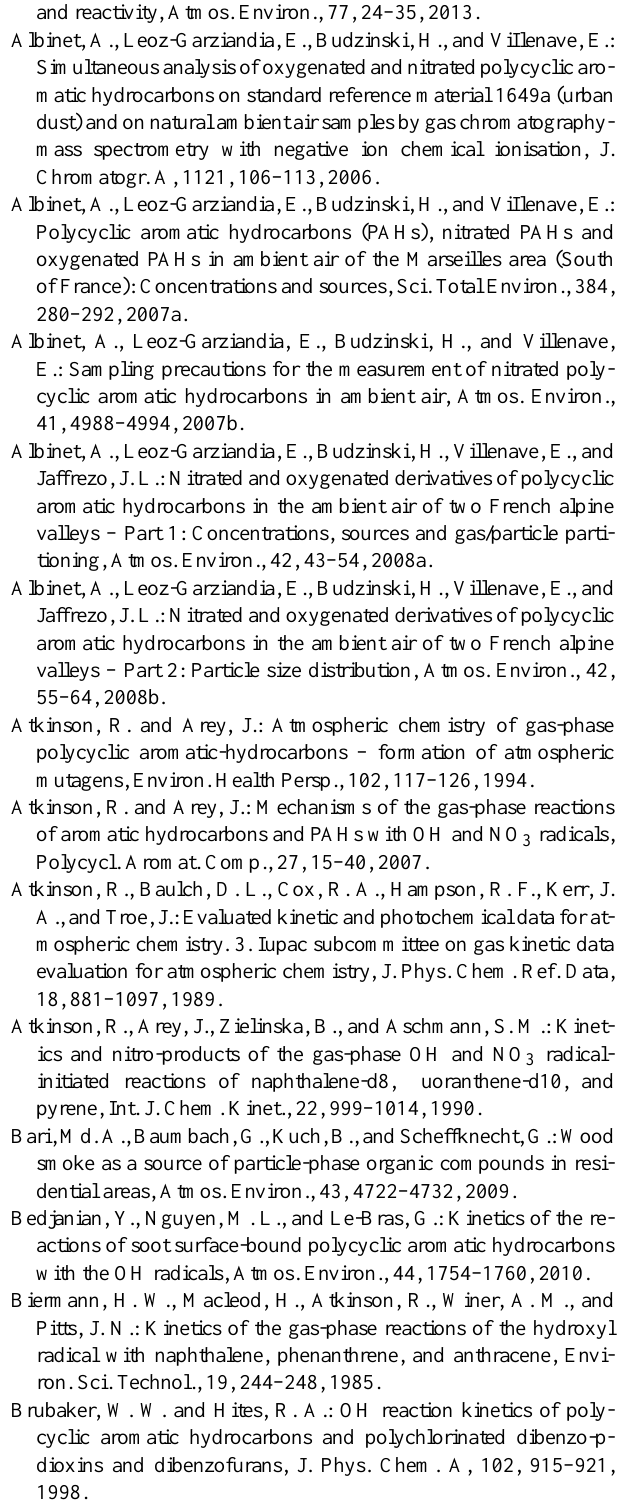
Table 2. Average gas phase rate coefficients of LMW PAH com- pounds found in literature and their corresponding calculated ur- ban / rural reactivity ratios.